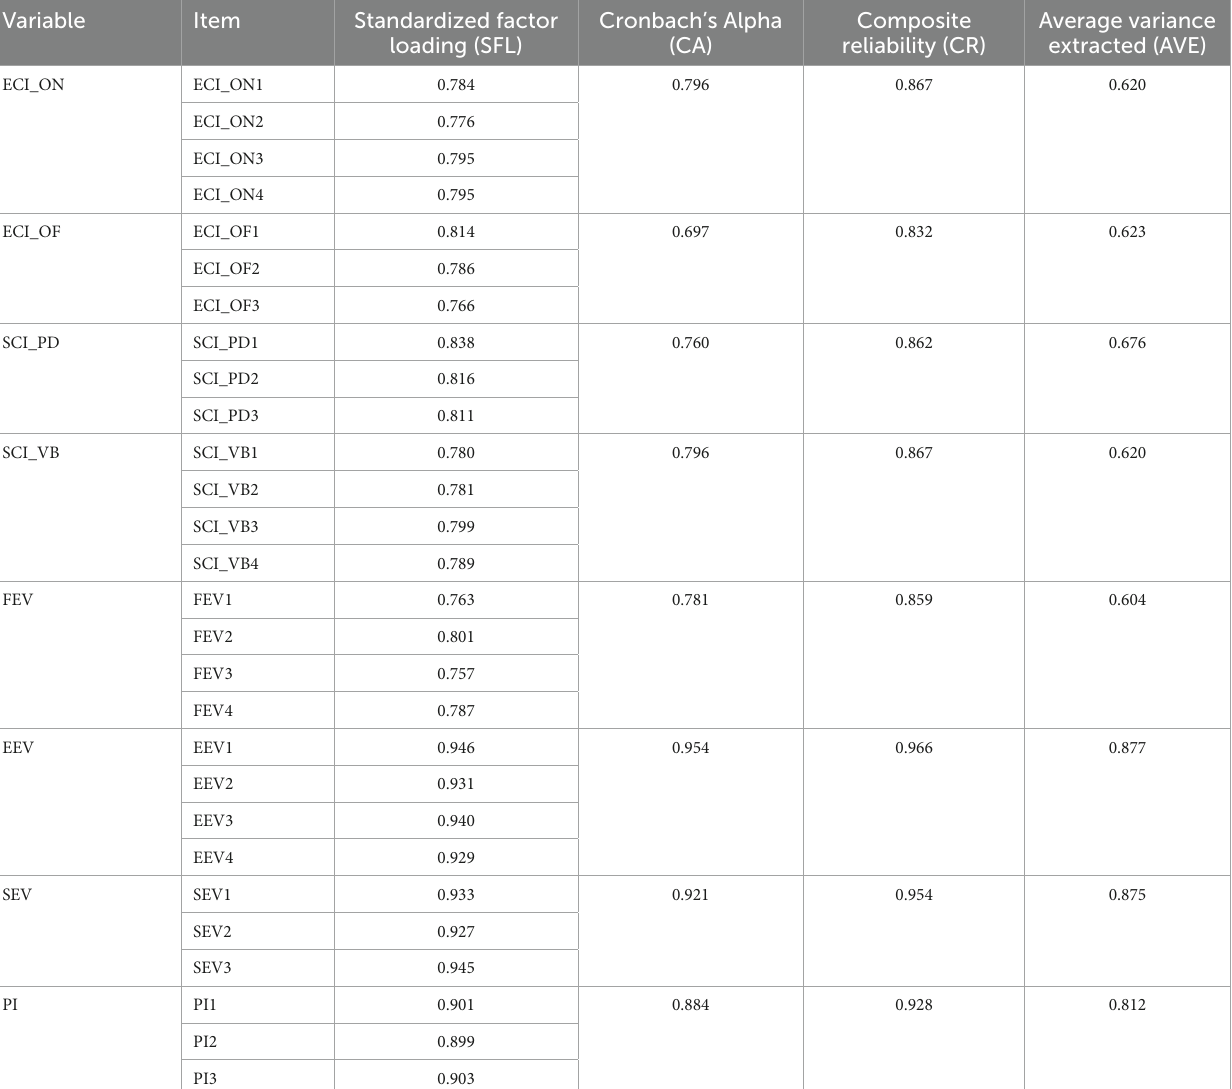
TABLE 2 Model results of SFL, CA, CR, and AVE.